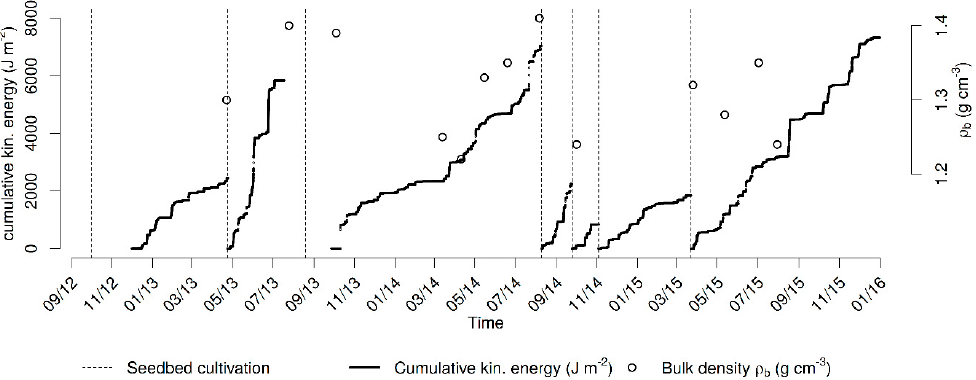
Figure 9. Seasonal variability of the bulk density ( ρ d ) related to cumulative rainfall kinetic energy. Seedbed cultivation (dashed line) is assumed to interrupt the effect of the previous rainfall.